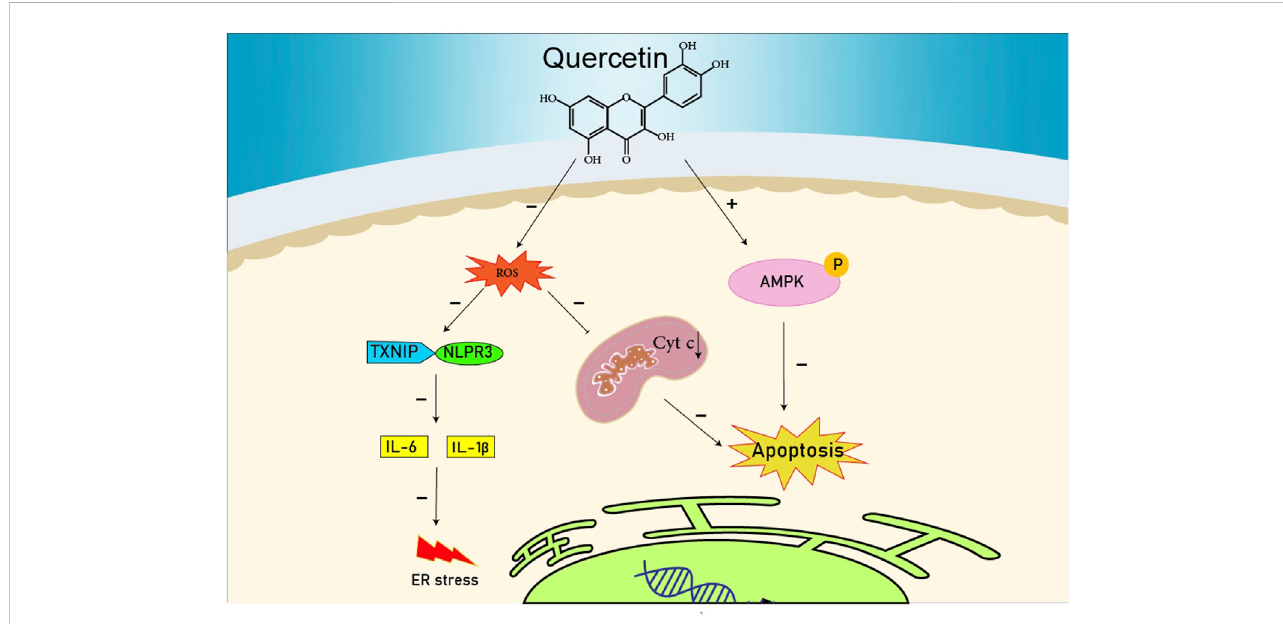
The reduction of ROS production by quercetin decreases TXNIP and NLPR3, which in turn results in a reduction of endoplasmic reticulum stress by reducingIL1BandIL6.Ontheotherhand,thereductionofROSreducestheproduction ofCyt cinthemitochondria,whichultimatelyreducesapoptosis.The compound also increases AMPK phosphorylation in the endothelial cells, causing an increase in NO production and eventually a decrease in